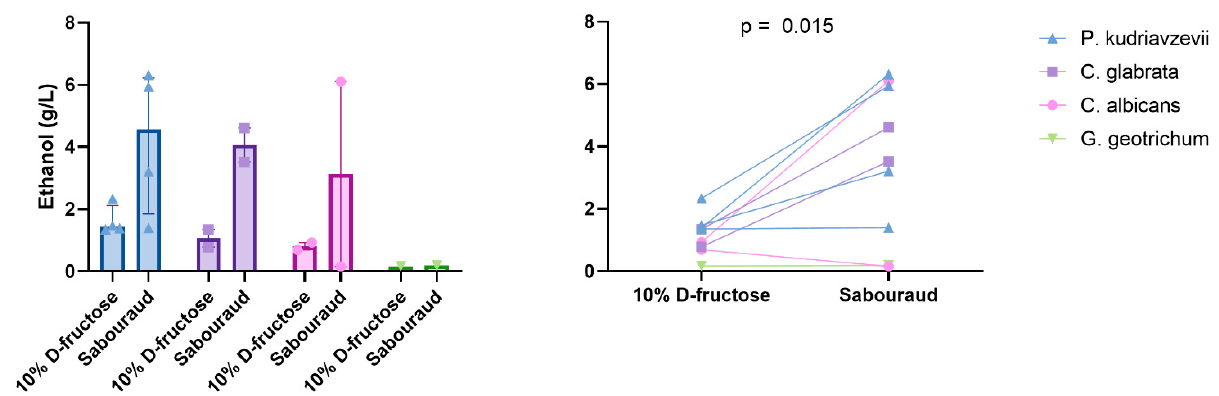
Figure 7. Ethanol production by gut yeasts according to species and medium. Median and interquartile are shown. Paired two-tailed t -test.